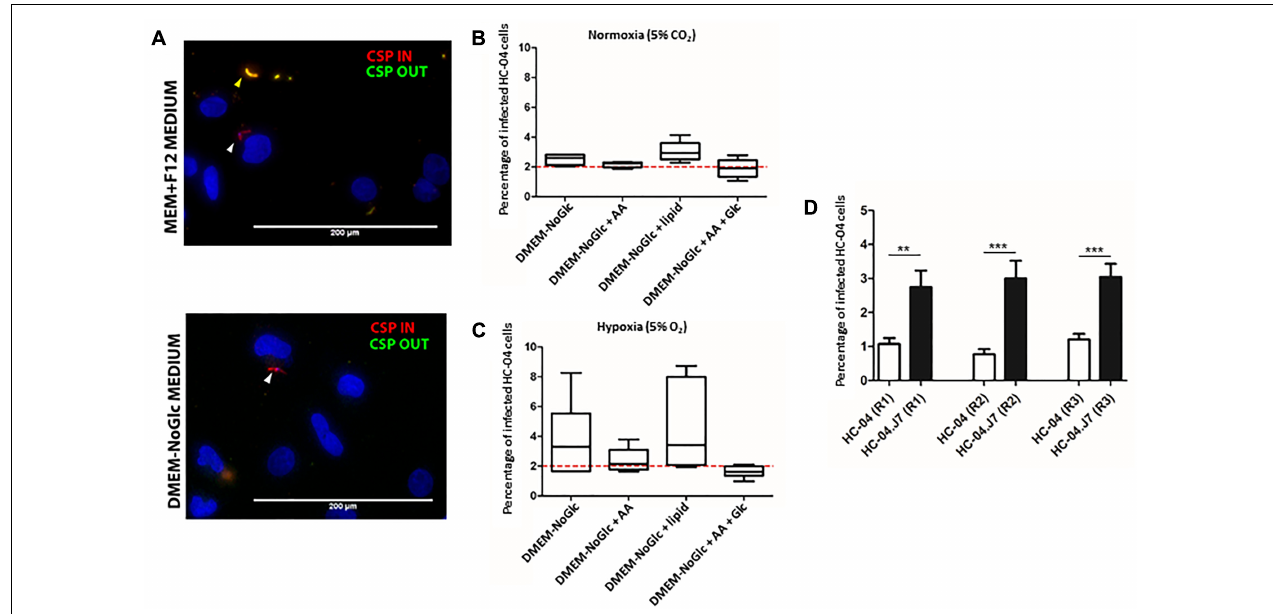
FIGURE 2 | Establishment of an optimized in vitro system for Plasmodium falciparum sporozoite invasion. (A) Inside-outside staining of P. falciparum sporozoites in HC-04 cells after 24 h. Red staining denotes sporozoites inside cells; yellow staining denotes sporozoites outside cells. Scale bars = 200 µ m. (B,C) The invasion efficiency of P. falciparum NF54 sporozoites in HC-04 (parental) cells grown under normoxic conditions (5% CO 2 ) (B) or in 5% oxygen (C) . The dashed red line at 2% indicates the highest invasion percentages reported in the literature using primary human hepatocyte monoculture. AA: amino acids (arginine, cysteine, histidine, isoleucine, leucine, lysine, methionine, phenylalanine, threonine, tryptophan, tyrosine, valine). Lipid: arachidonic, linoleic, linolenic, myristic, oleic, palmitic, stearic, cholesterol, Tween-80, tocopherol acetate, and Pluronic F-68. Glc: 15 mM D -glucose was added at the time of sporozoite addition. (D) The invasion efficiency of P. falciparum NF54 sporozoites isolated from the same pool of mosquitoes in parental HC-04 and the HC-04.J7 subclone grown in DMEM-NoGlc in three biological replicate (R1–R3) assays. Mean ± SEM is shown. P- values were calculated using a using a two-tailed Student’s t -test. ∗∗ P < 0.01, ∗∗∗ P < 0.001.